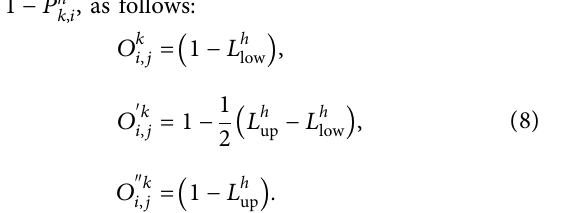
and T are in the agent’s CPM and 1 2 is beyond the agent’s uncertainty 3